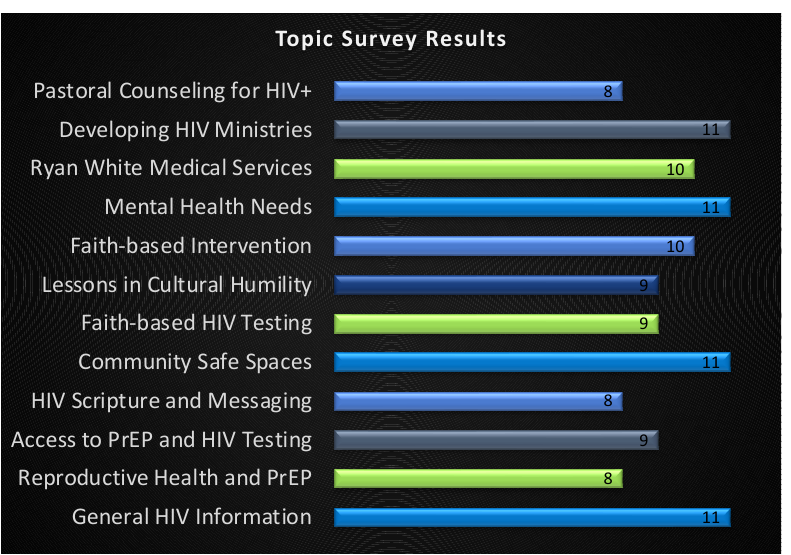
Figure 1. Faith Summit Topic Rankings (n = 12 responses recorded). There was a tie for 12 topics with the most votes from the survey. Topics were integrated into 1 session to condense (e.g., General HIV Information and PrEP and HIV testing). Data are displayed with total votes at the end of the data bars.